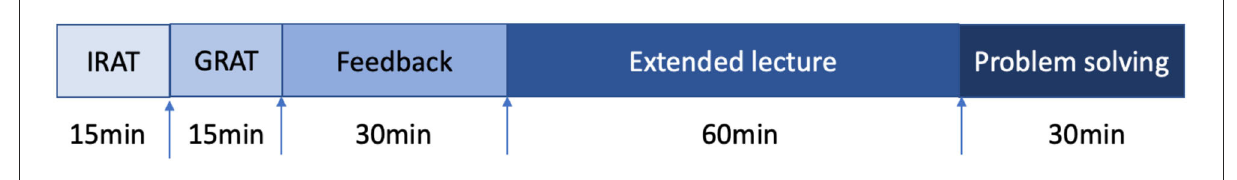
FIGURE1 Time schedule of team-based learning